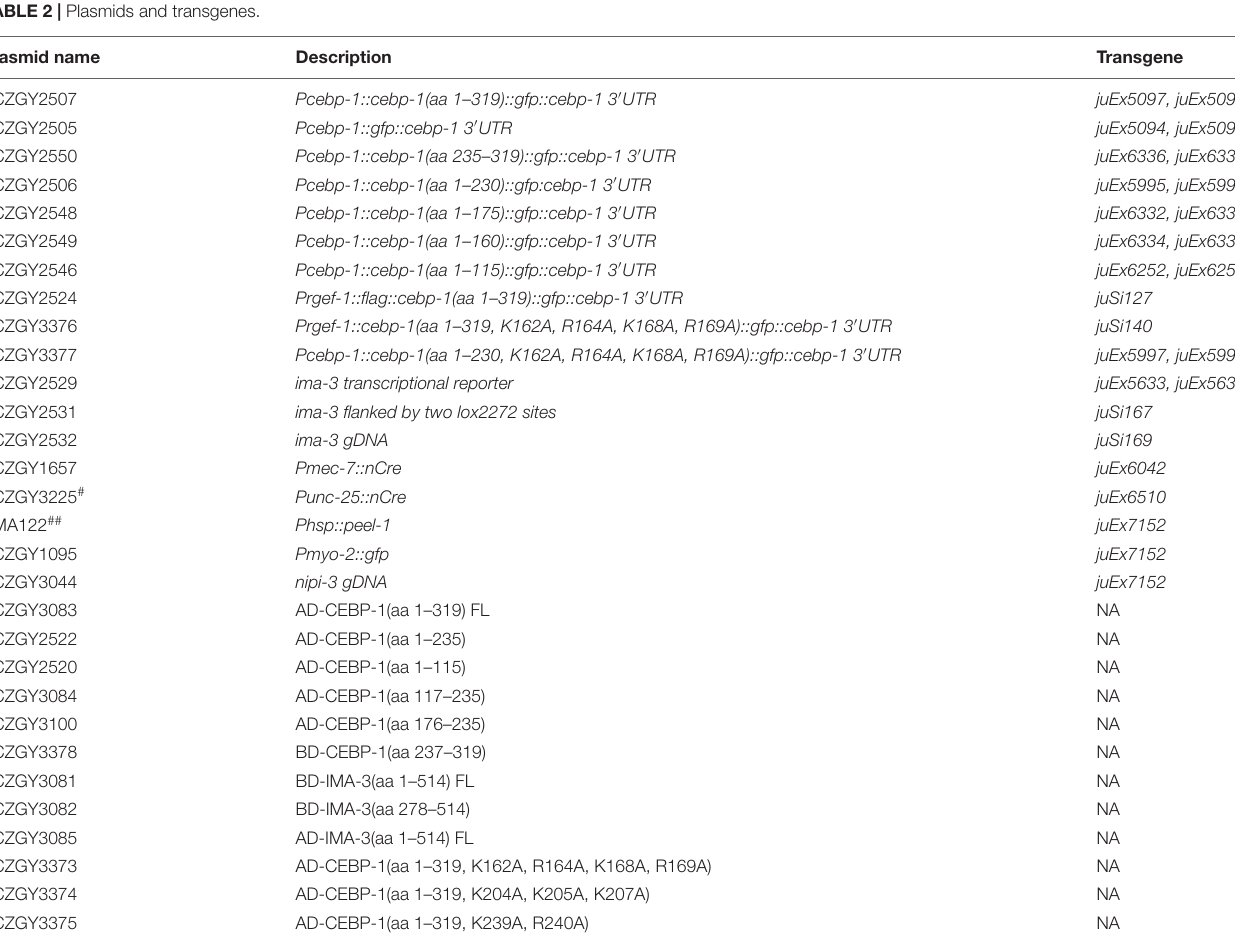
TABLE 2 | Plasmids and